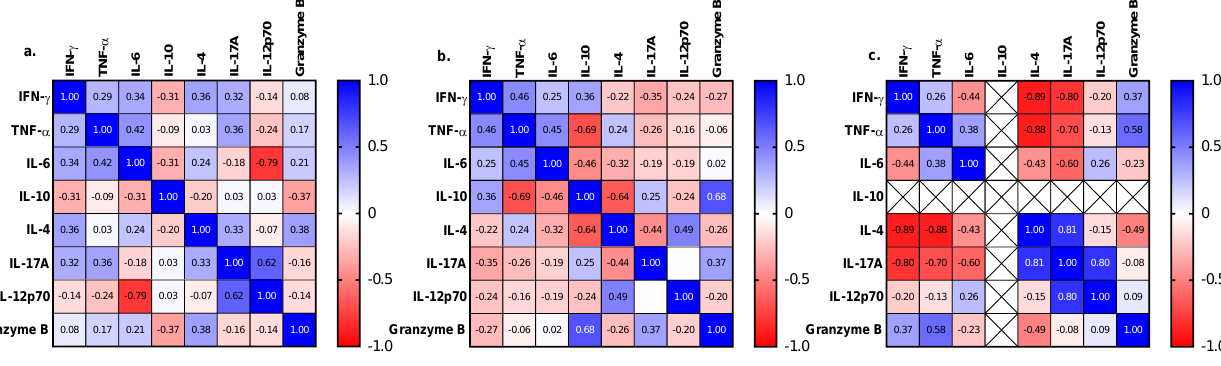
Figure 3. Heat map of Spearman rho correlations between cytokines measured in serum of participants with No-TB ( a ), DS-TB ( b ), and MDR-TB ( c ).